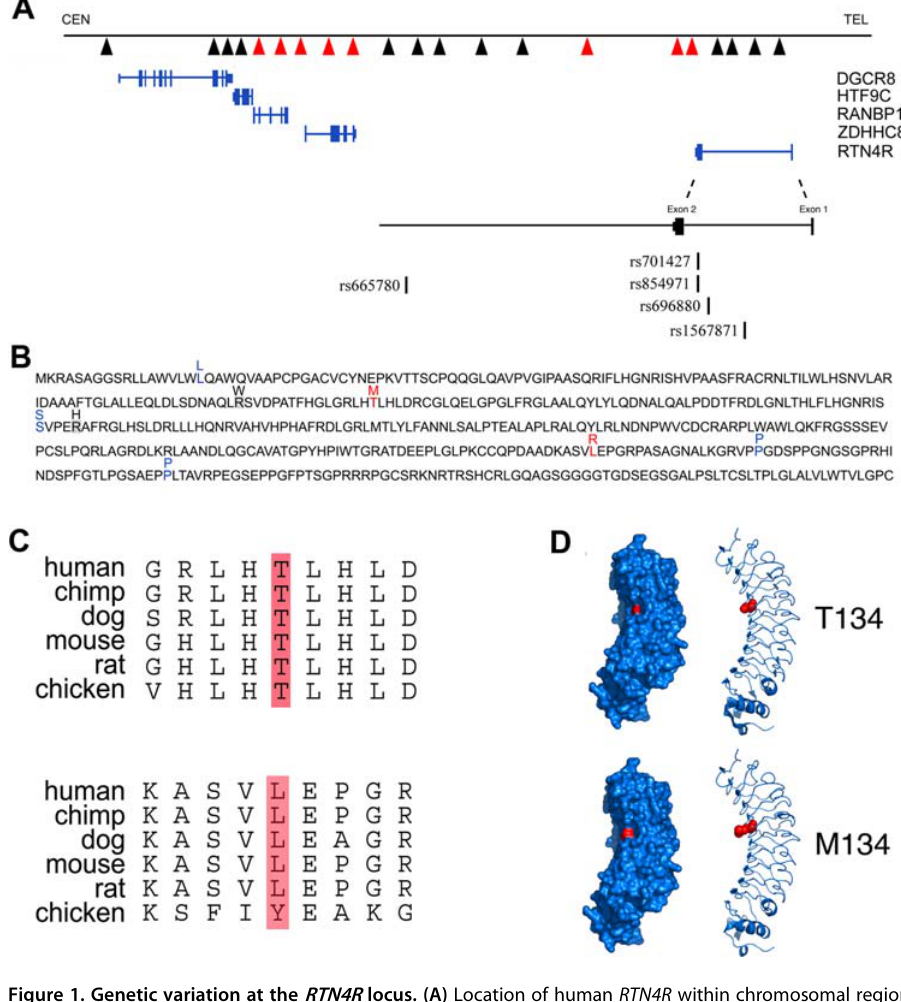
Figure 1. Genetic variation at the RTN4Rlocus. (A) Location of human RTN4R within chromosomal region 22q11.2. Exons are represented by blue bars. The rs numbers of the SNPs typed in the present study are shown. SNPs genotyped by Liu et al. [22] are indicated by arrowheads (those SNPs that showed significant association with schizophrenia are shown in red arrowheads). The association observed with the three SNPs at the 3 9 end of RTN4R was independent from the association observed more proximally in the vicinity of the ZDHHC8 gene [22]. (B) Complete amino acid sequence of RTN4R . Rare coding variants identified in the U.S. schizophrenia sample are shown in blue (synonymous) or red (missense). Two missense variants reported by Sinibaldi et al. [31] are shaded in grey. (C) Evolutionary conservation across species of the missense variants identified in this study at amino acid positions 134 (top) and 347 (bottom). (D) Surface (left) and cartoon (right) representation of the crystal structure of the ligand-binding ectodomain of RTN4R. The variant at residue 134, drawn in red, is shown as the wild-type threonine (top) and the mutated methionine (bottom).